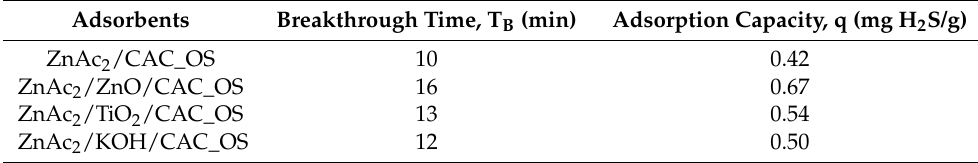
Table 2. Adsorption capacity of CS/CAC_OS